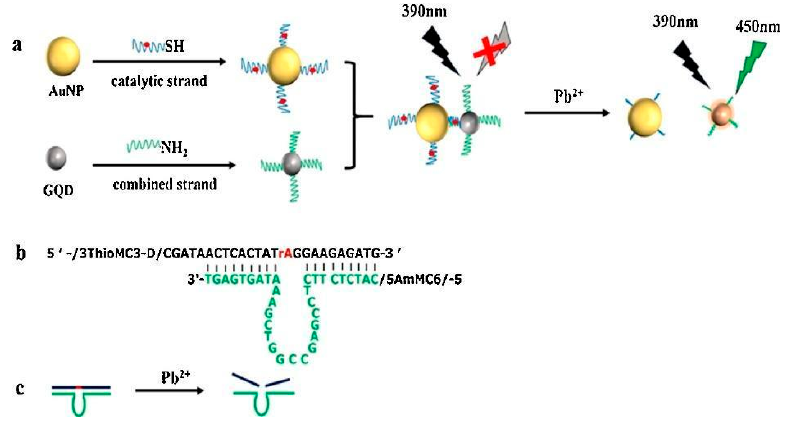
Figure 6. ( a ) Schematic illustration of Pb(II) detection based on energy transfer between graphene quantum dots (GQDs) and nanoparticles (NPs). ( b ) Structure formula of combined GQDs and AuNPs. ( c ) Scheme of catalytically cleave of the DNA molecule (reprinted from [100] with permission from Elsevier).